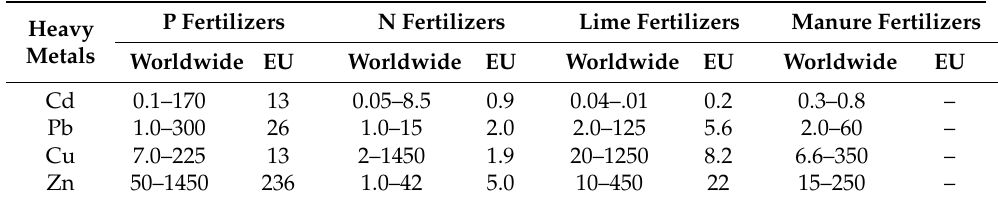
Table 2. Comparison between heavy metal concentrations (mg·Kg −1 ) in different types of fertilizers and livestock manure around the world and in the EU (Modified from Alloway [28]).